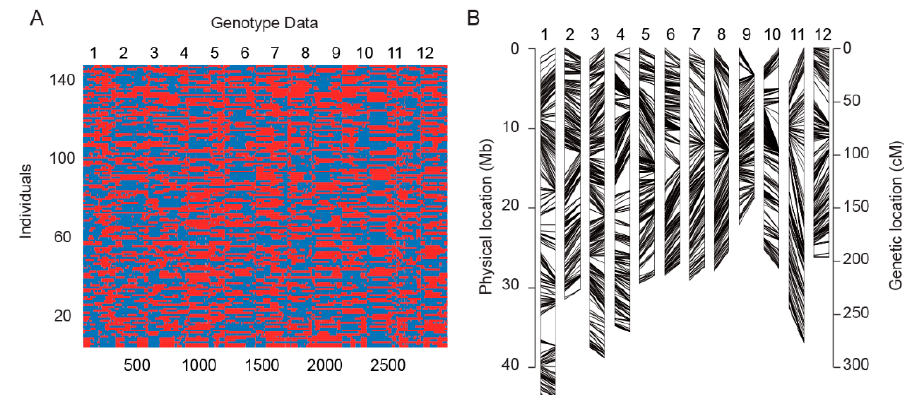
Figure 2. High-resolution genotyping and comparison of the physical maps and genetic maps of RILs. ( A ). Aligned recombination maps of 144 RILs from a cross between LTH and SN265. The two genotypes are indicated by blue (SN265) and red (LTH); ( B ). Comparison of the physical maps and genetic maps. Left: physical map. Right: genetic map. Table 1. Characteristics of the high-density genetic map derived from a cross between LTH and SN265.